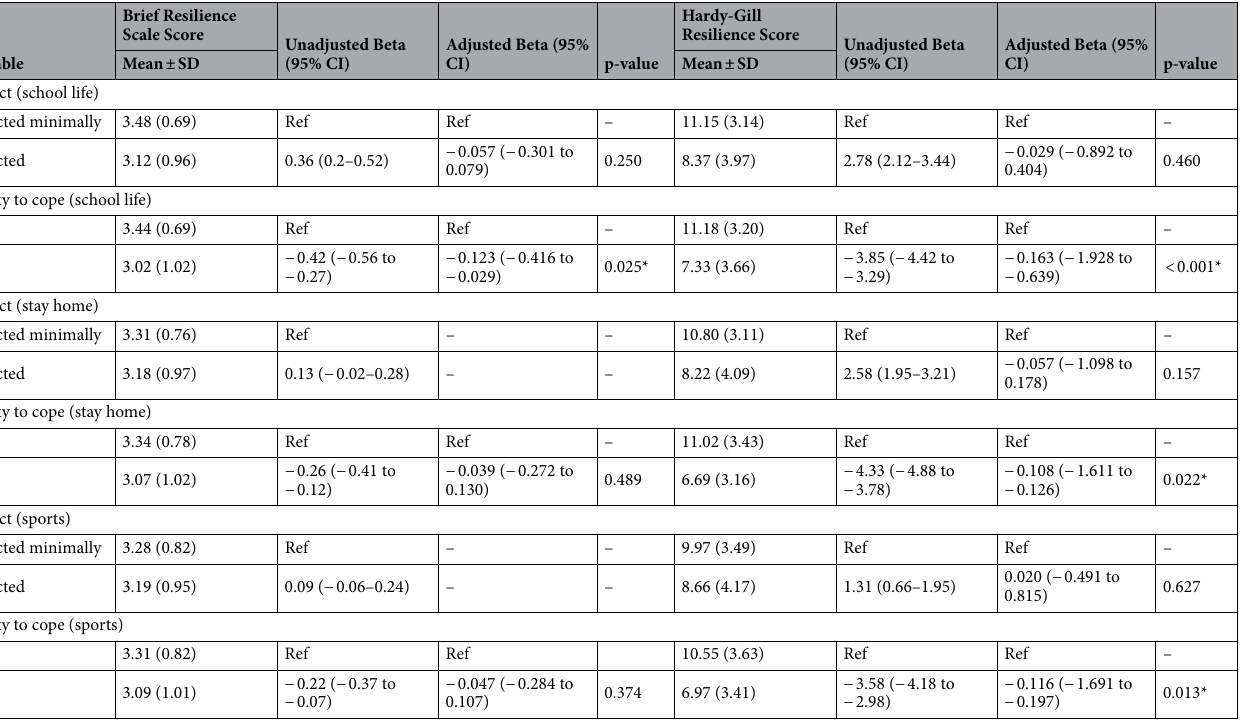
Table 4. Association between life setting and resilience score. *p < 0.05. Model for BRS is adjusted for ethnicity and housing type. Model for HGRS is adjusted for gender, nationality, ethnicity and education